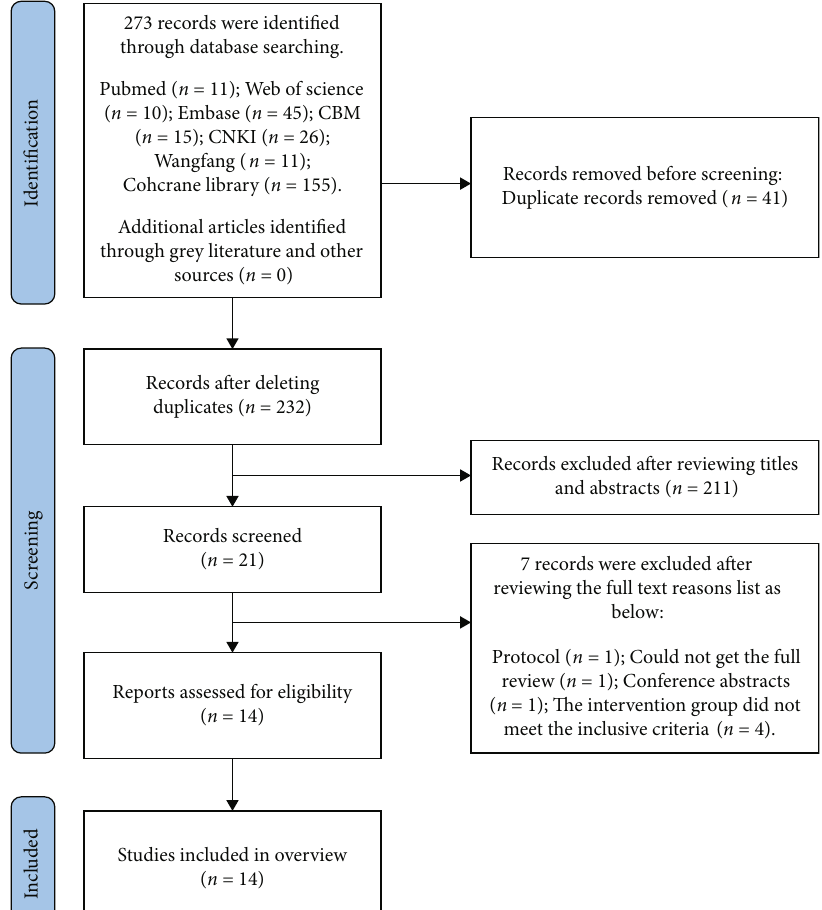
Figure 1: Flow diagram of the literature screening